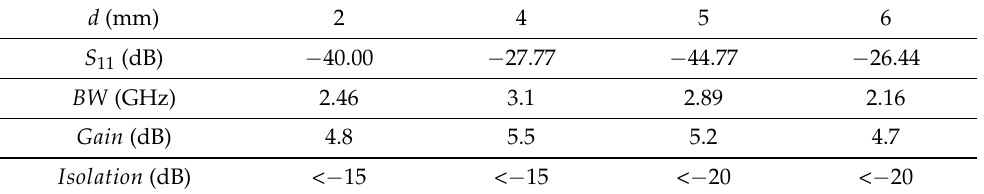
Table 1. Performance of the MIMO configuration-I antenna at 28